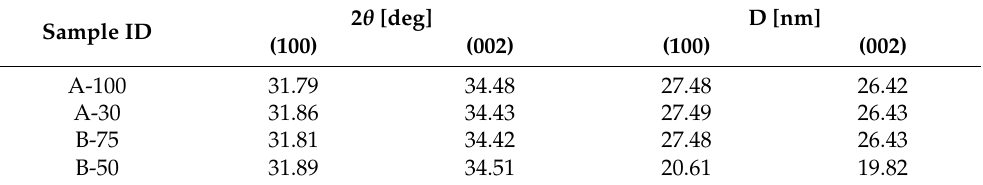
Table 3. Position of main XRD peaks and calculated crystallite size of examined ZnO